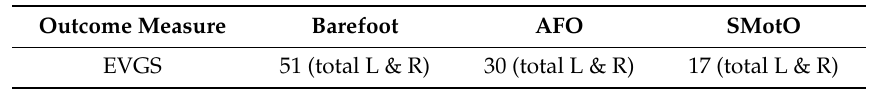
Figure 5. Participant 5. Table 6. Participant 5 comparative Edinburgh Visual Gait Score (EVGS) results between barefoot, AFO and